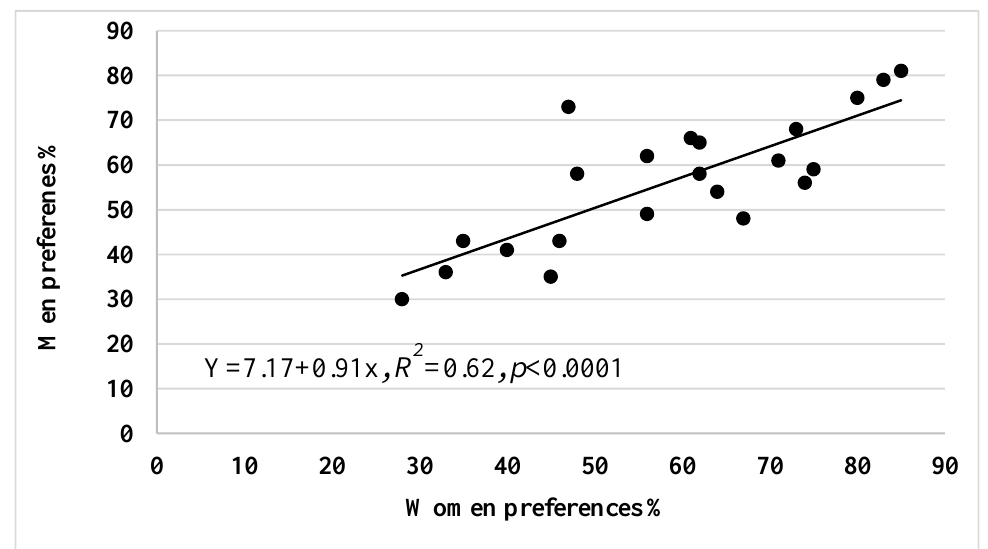
PI = Preference index.